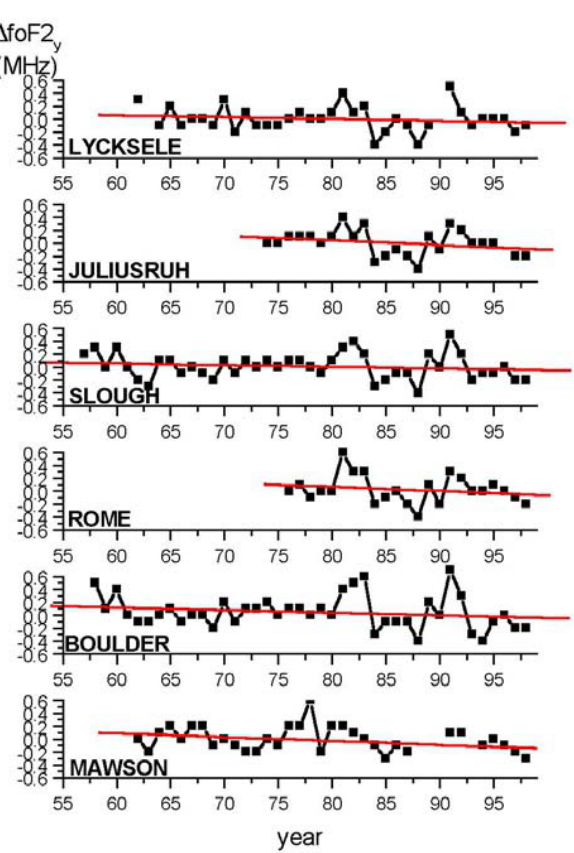
Fig. 1. Yearly f oF 2 residuals ( 1f oF 2 y ) for each ionospheric sta- tion